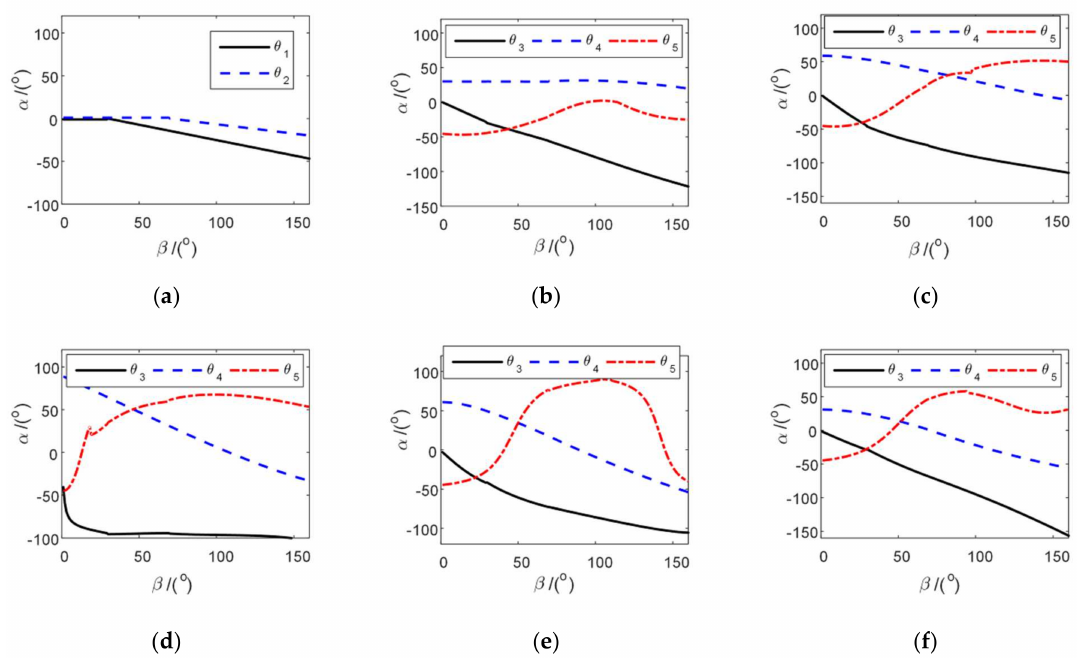
Figure 11. Changes in motion parameters in the 0 ◦ , 30 ◦ , 60 ◦ , 90 ◦ and 120 ◦ lifting planes. ( a ) The lift angle corresponds to ( i = 1,2 ) and the angle relationship 0 ◦ ; ( b ) the rotational angle of each joint in the lifting plane 0 ◦ ; ( c ) the rotational angle θ 2 i of each joint in the lifting plane 30 ◦ ; ( d ) the rotational angle of each joint in the lifting plane 60 ◦ ; ( e ) the rotational angle of each joint in the lifting plane 90 ◦ ; ( f ) the rotational angle of each joint in the lifting plane 120 ◦ .